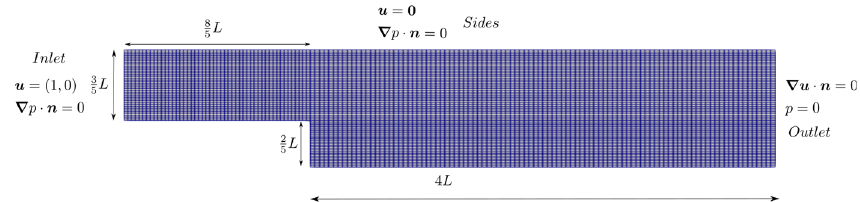
Fig. 1 The computational domain used in the numerical simulations of the flow past a backward step, all lengths are described in terms of the characteristic length L that is equal to 1 meter